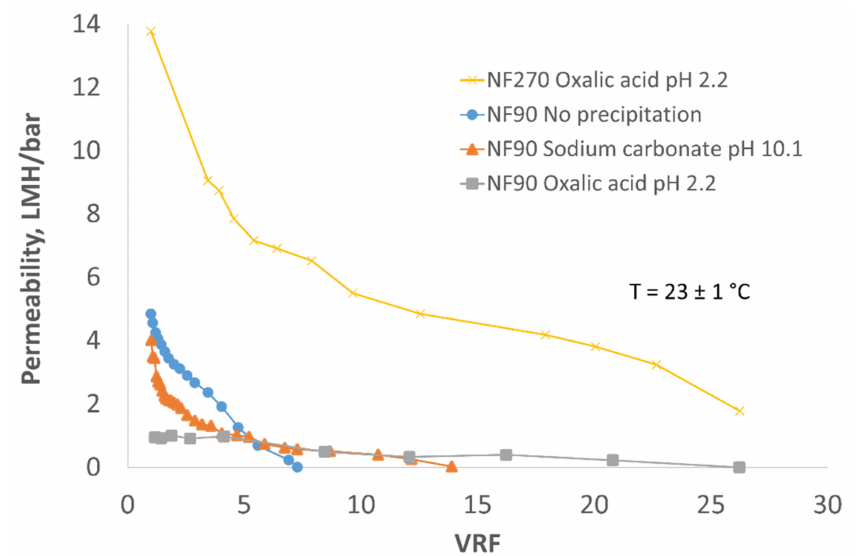
Figure 2. Concentration of pre-treated mine water using NF90 with no precipitation, precipitated using Na 2 CO 3 and precipitated C 2 H 2 O 4 compared to NF270 precipitated with C 2 H 2 O 4